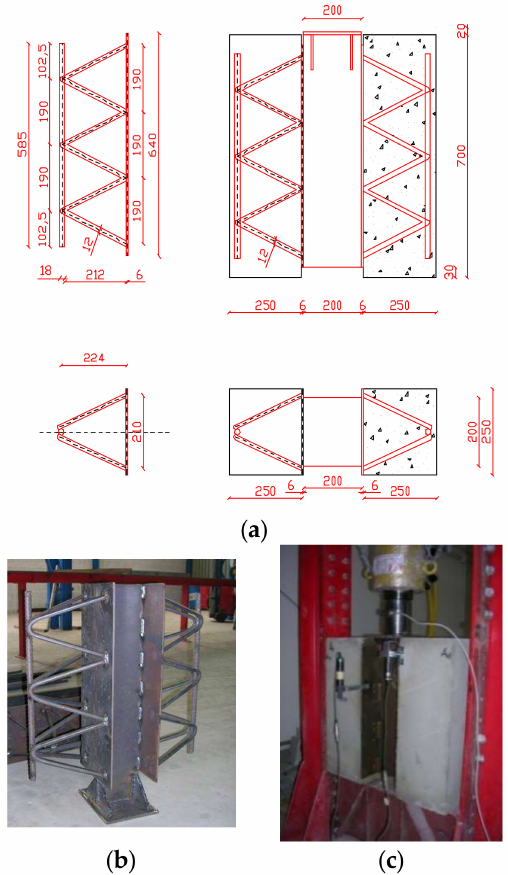
Figure 7. Push-out test in Phase II (Aiello). [5]: ( a ) geometry of specimens (dimensions in mm); ( b ) steel truss before casting; ( c ) specimen into the testing